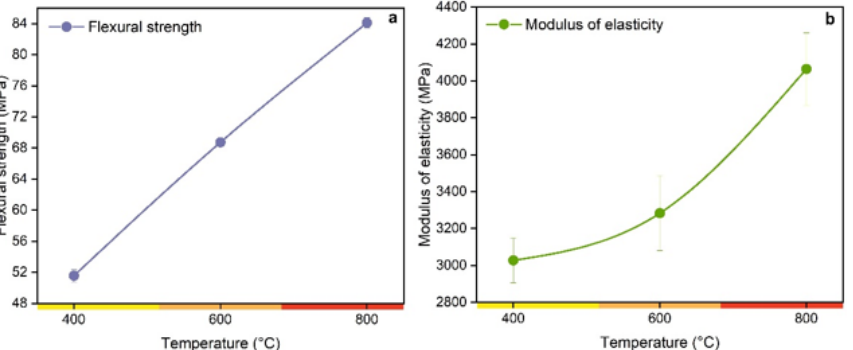
Figure 7. ( a ) Flexural strength and ( b ) modulus of elasticity of biocomposite produced with charcoal fines produced at different pyrolysis temperatures.